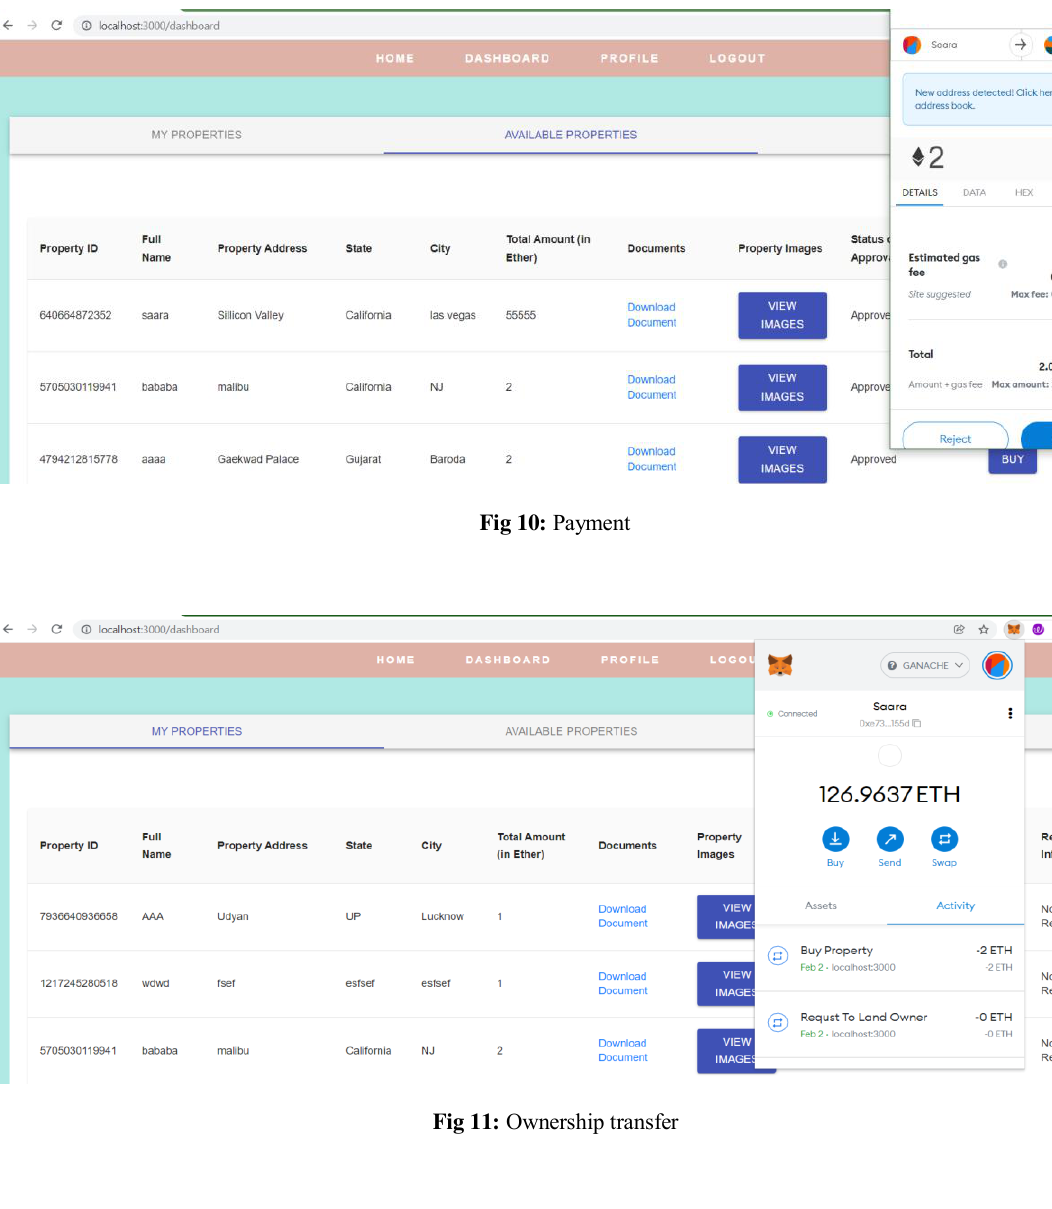
Fig 9: Acceptance/Rejection of request by owner